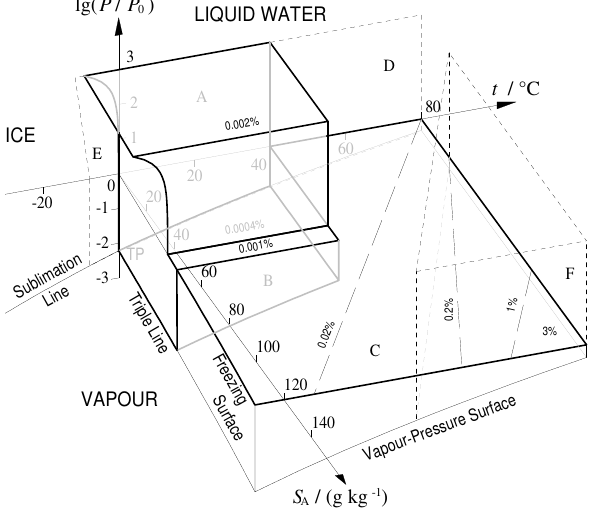
Fig. 3. Range of validity of the IAPWS-08 Gibbs function of seawa- ter and uncertainty of density estimates calculated from this func- Fig. 3 Range of validity of the IAPWS-08 Gibbs function of seawater and uncertainty tion. Region A : oceanographic standard range, B : extension to of density estimates calculated from this function. Region A: oceanographic standard higher salinities, C : hot concentrates, D : zero-salinity limit, E : ex- range, B: extension to higher salinities, C: hot concentrates, D: zero-salinity limit, E: trapolation into the metastable region below 0 ◦ extrapolation into the metastable region below 0 °C.